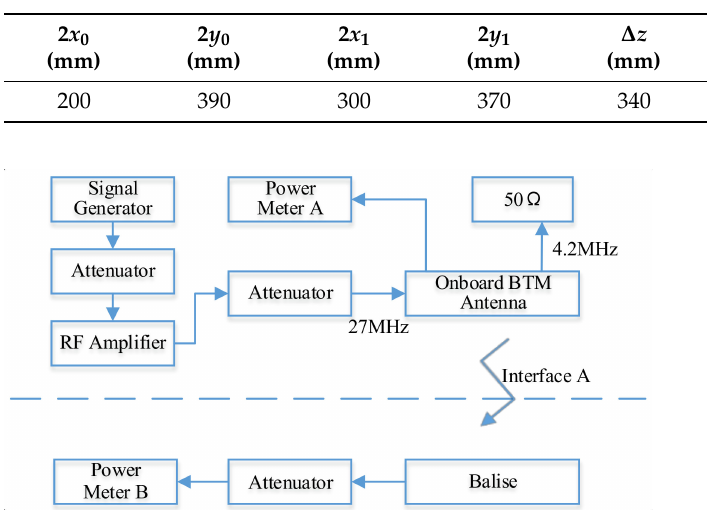
Table 2. Some typical parameters of the OAU and the passive balise (Part A).